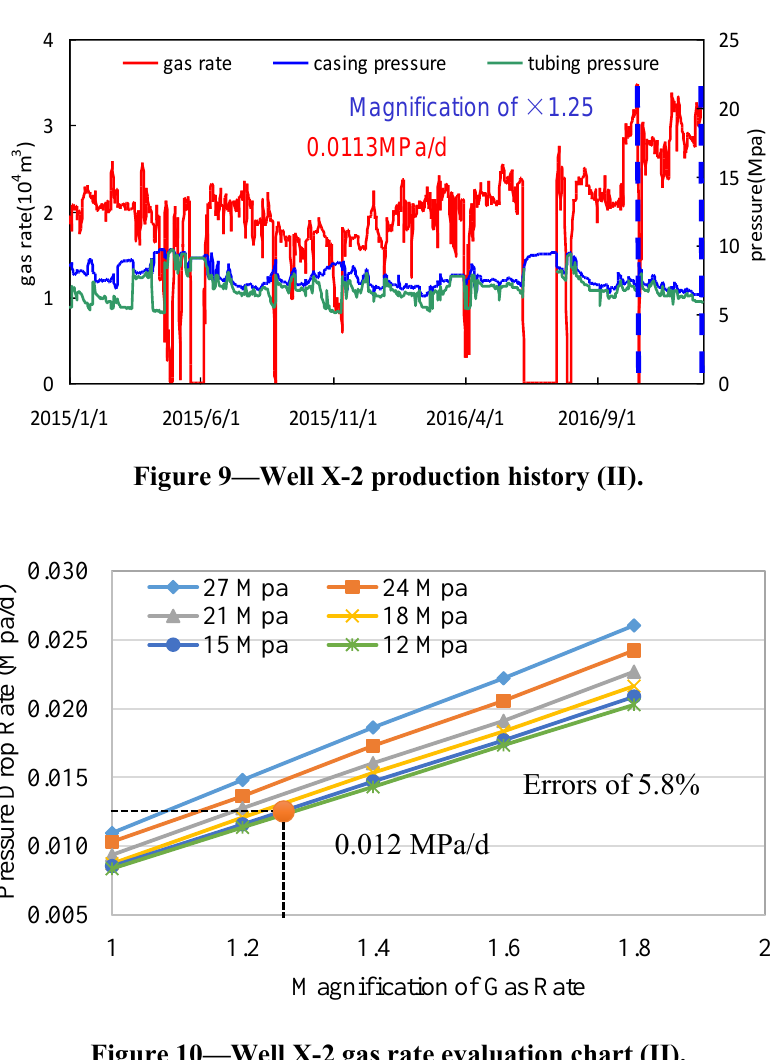
Figure 10—Well X-2 gas rate evaluation chart